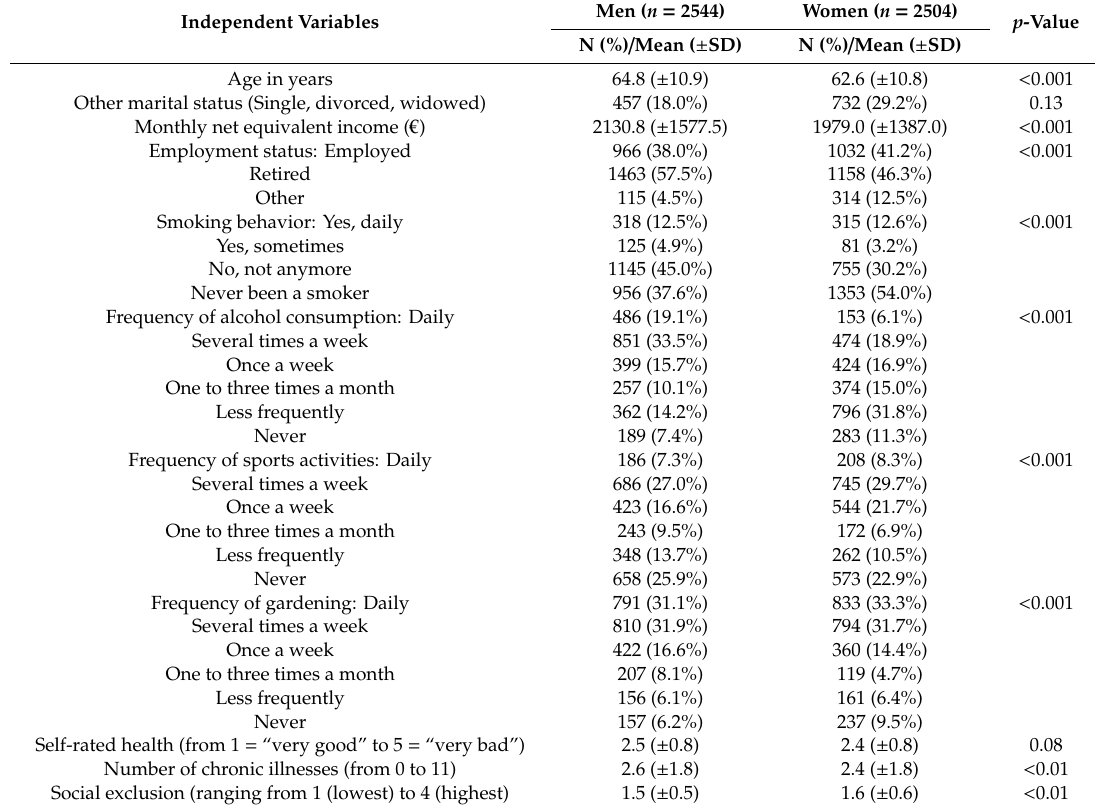
Table 1. Sample characteristics stratified by sex ( n =